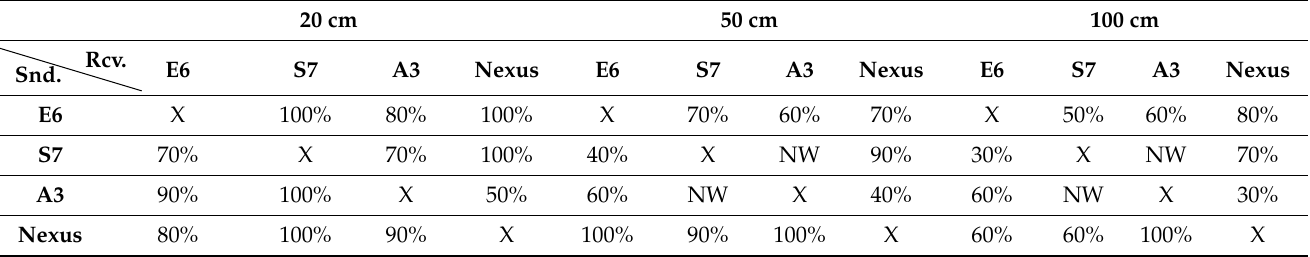
Table 4. Pairing success rate for indoors experiments (16.7–20 KHz